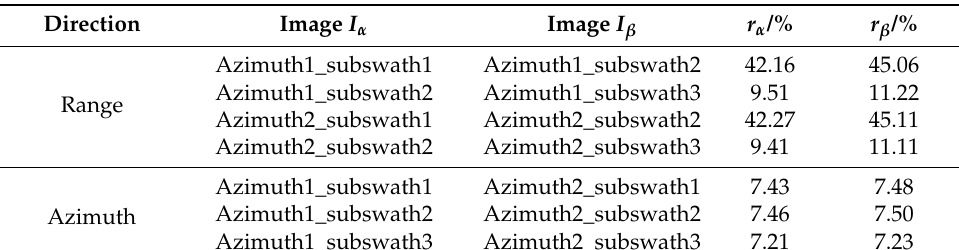
Table 6. Overlapping rates between adjacent images.